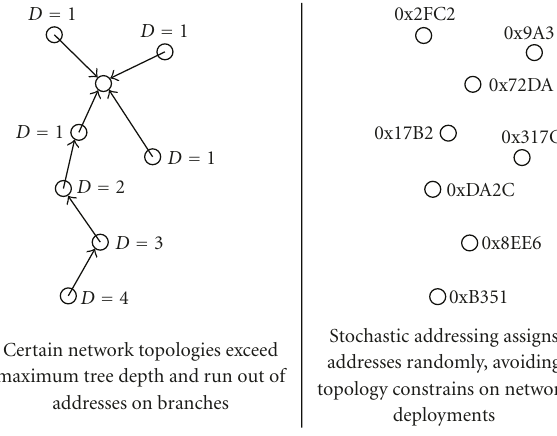
Figure 5: Tree-based addressing and stochastic addressing [5].